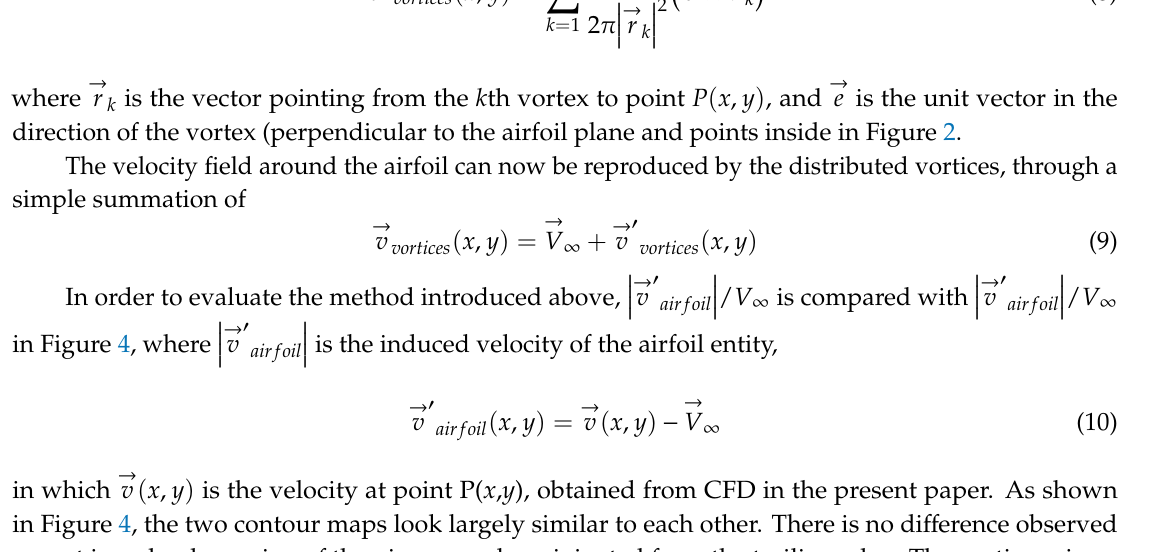
α = 6 ◦ , Reynolds number =